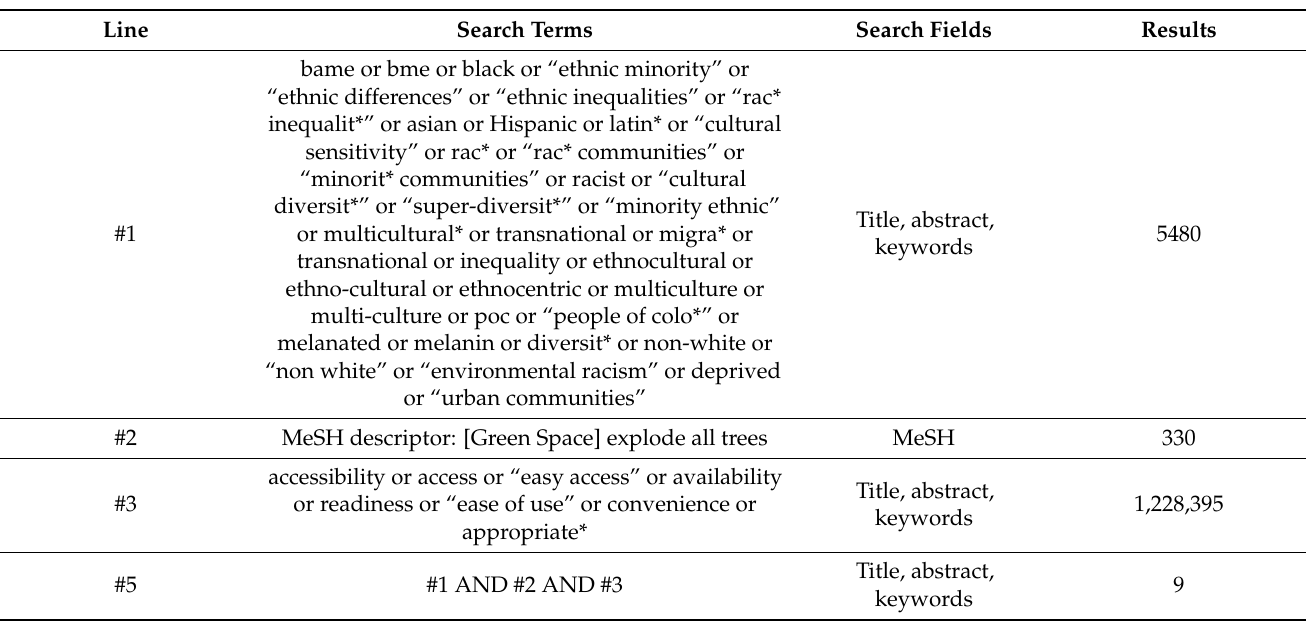
Table A4. Cochrane Database of Systematic Reviews (CDSR) Cochrane Central Register of